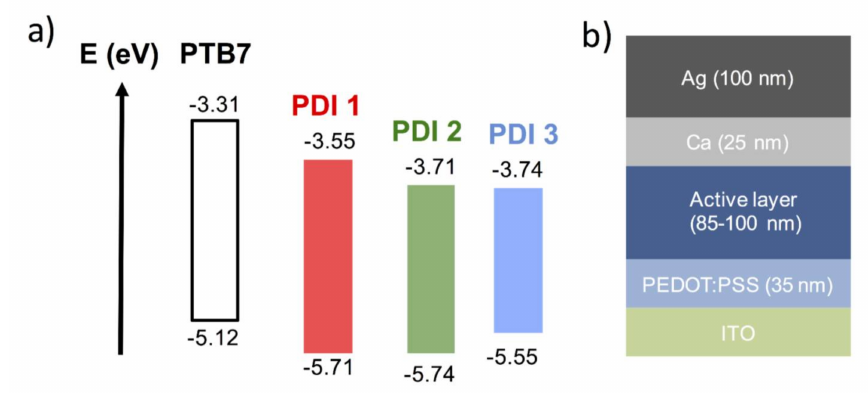
Figure 2. ( a ) HOMO and LUMO energy levels of the three PDIs; ( b ) Solar cell device architecture.